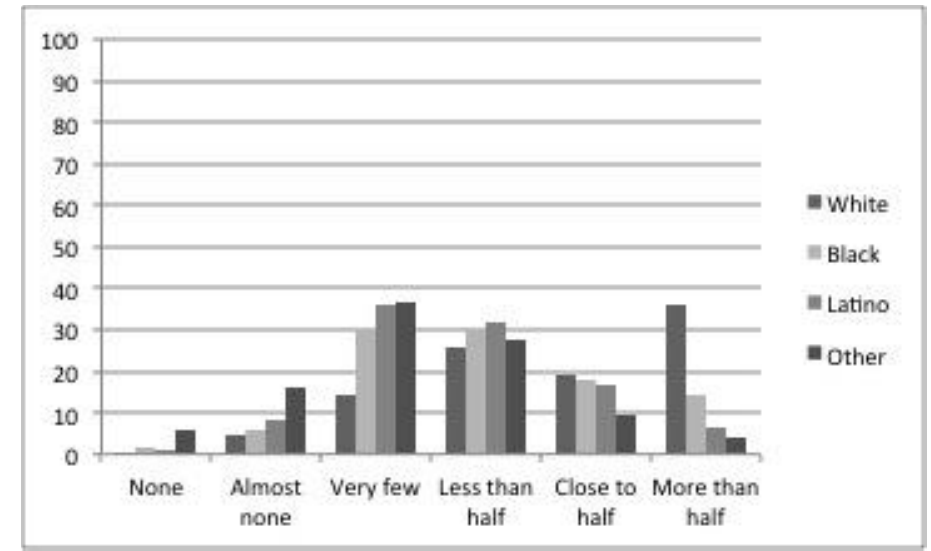
Figure 1. Perceptions of the size of racial/ethnic groups in a respondent’s neighborhood.